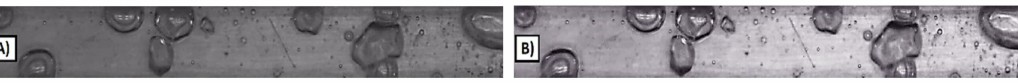
Figure 8. Picture of two-phase flow ( A ) before and ( B ) after the operations improving its